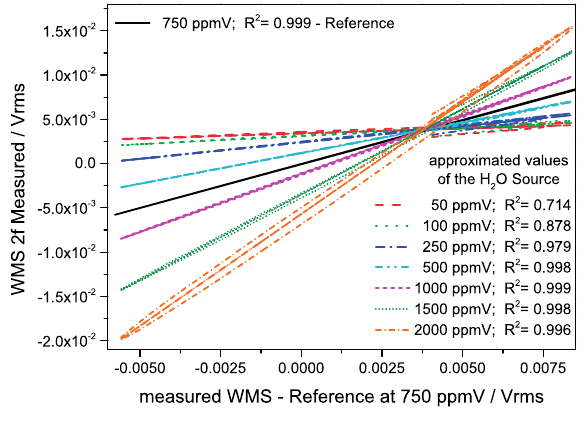
Figure 10. Correlative linear fits of the measured 2f/1f spectra for several H 2 O concentration levels against a reference spectrum at 750